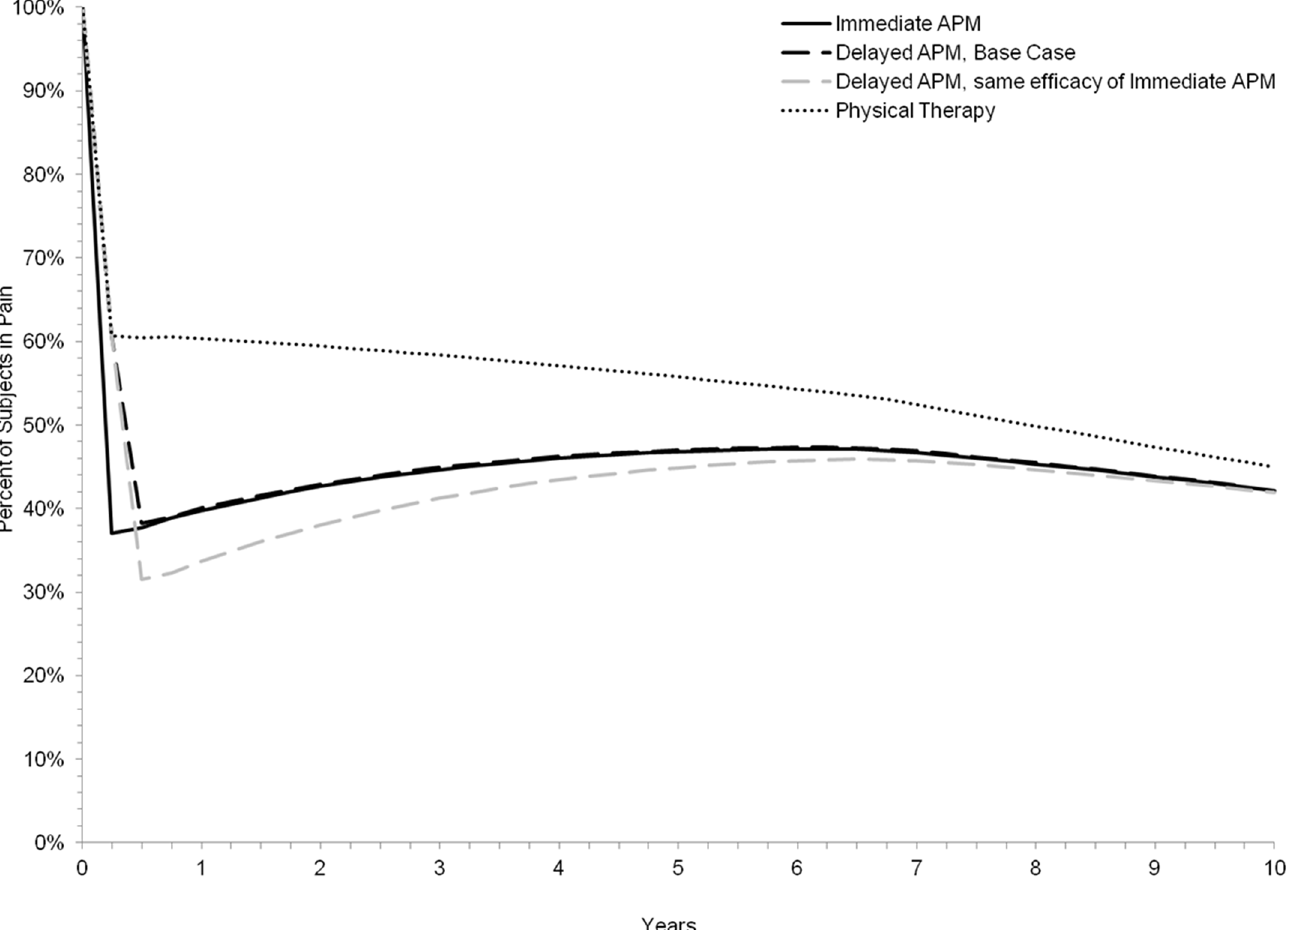
Fig 2. Percentage of Subjects in Moderate Pain, Stratified by Treatment Arm. Fig 2 describes the percentage of subjects reporting pain within each of the evaluated three treatment strategies over the course of 10 years. Two trajectories are reported for the Delayed APM strategy, represented in black and gray dashed lines in the graph. The black dashed Delayed APM trajectory reflects the base case, where the surgery ’ s efficacy was calculated based on results reported by MeTeOR subjects who crossed over from the non-operative to the operative arm between months 3 and 6. The gray dashed ‘ Delayed APM ’ line reflects the sensitivity analysis of Delayed APM, where we assumed the efficacy of a delayed surgery following a failed PT regimen would be equal to that of an APM procedure immediately following a MT